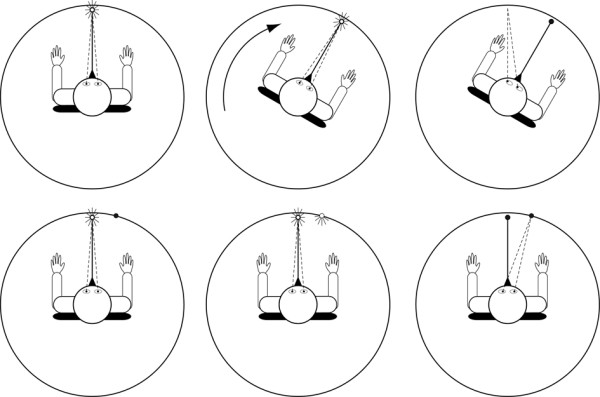
experimental conditions. Schematic of the experimental set-up: the upper panels depict the vestibular condition and lower panels the visual condition. Participants looked at a chair-fixed light (CFL) before being submitted to whole-body rotation (upper left panel). Then, the whole-body rotation stimulated mainly the horizontal semicircular canals (upper middle panel). Following the rotation, the CFL was turned off and the participants performed a saccade to the starting position (upper right panel). In the visual condition, the participants looked at the CFL (lower left panel). Then, the peripheral target lit up for 0.2 s (lower middle panel). Finally, following 1 s, the CFL was turned off and the participants performed a saccade to the peripheral target (lower right panel).